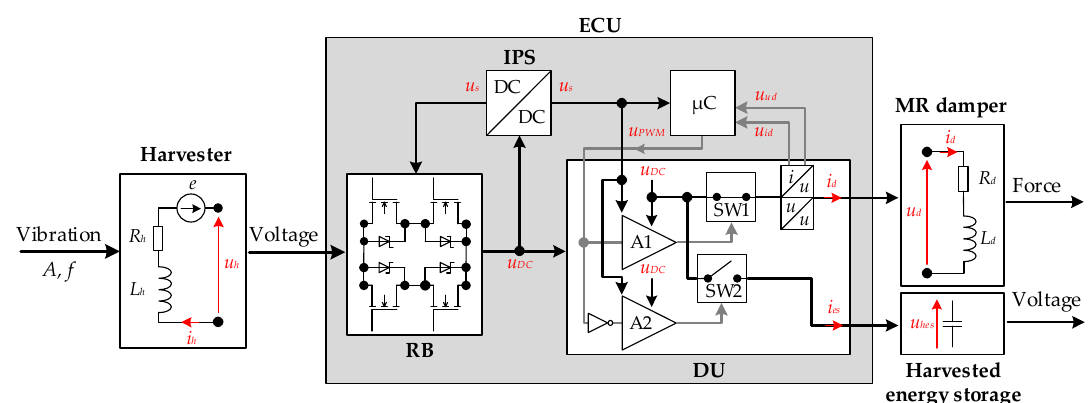
Figure 1. Architecture of the electrical control unit.